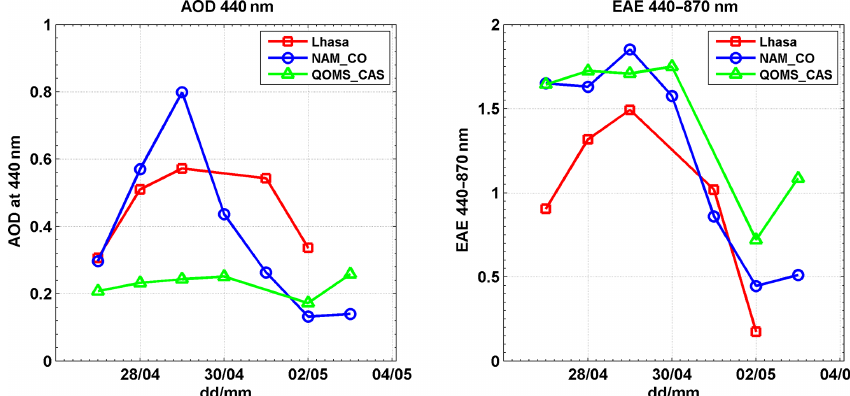
Figure 13. CE318-observed daily AOD and EAE during 27 April–3 May 2016 at Lhasa, NAM_CO and QOMS_CAS.